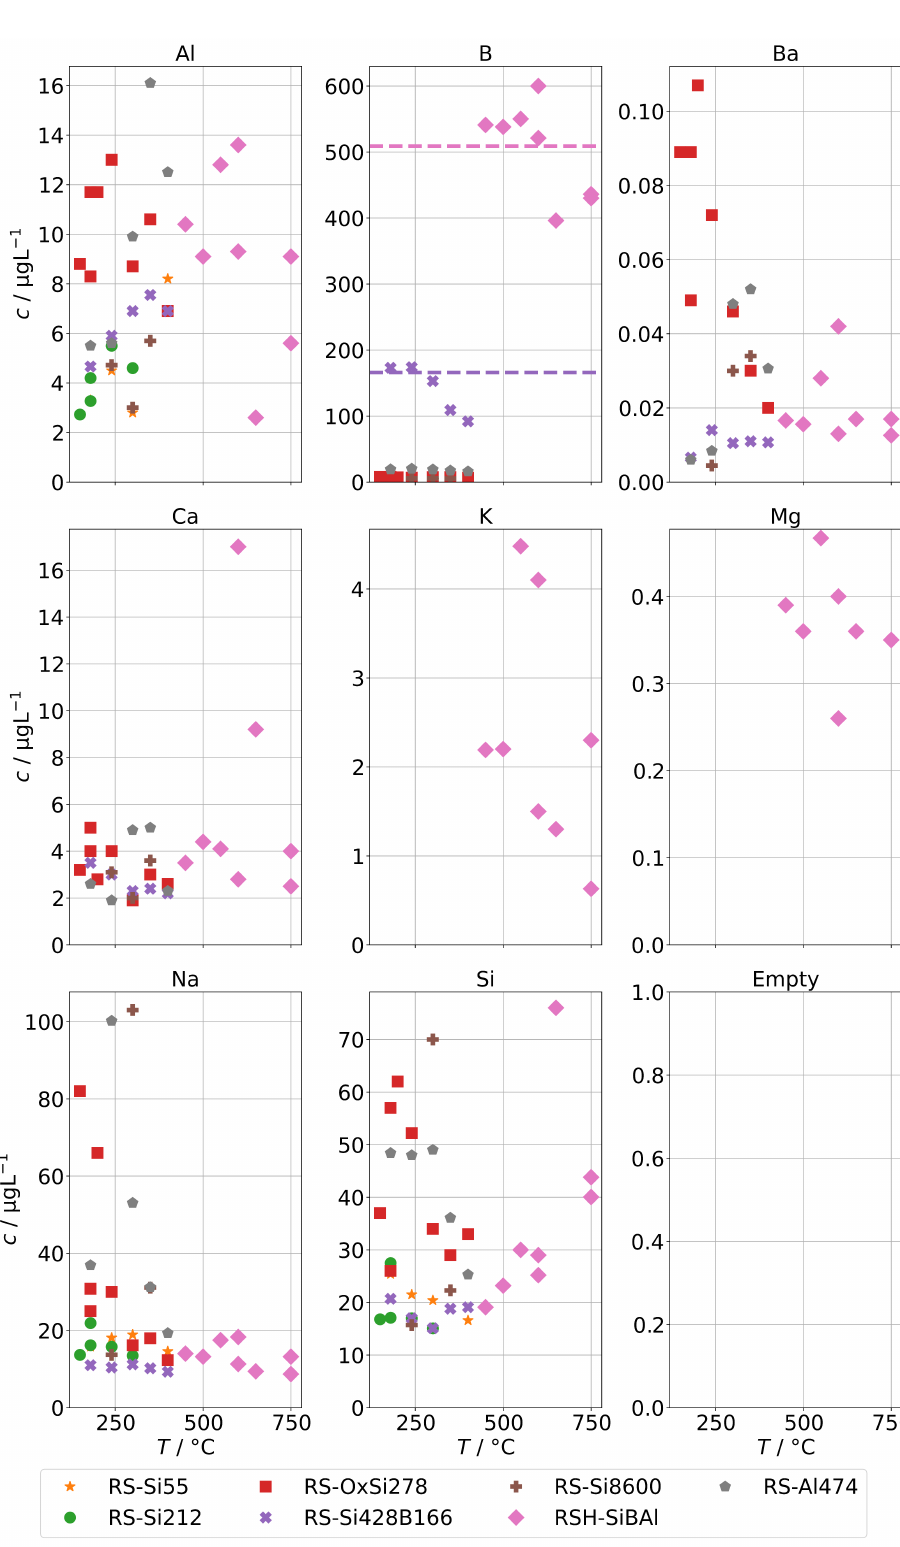
Figure 10. Concentrations of quantifiable species in condensates of the AG-SG obtained with spiked feed-water (group B) in dependence of operation temperature. Dashed lines indicate feed-water